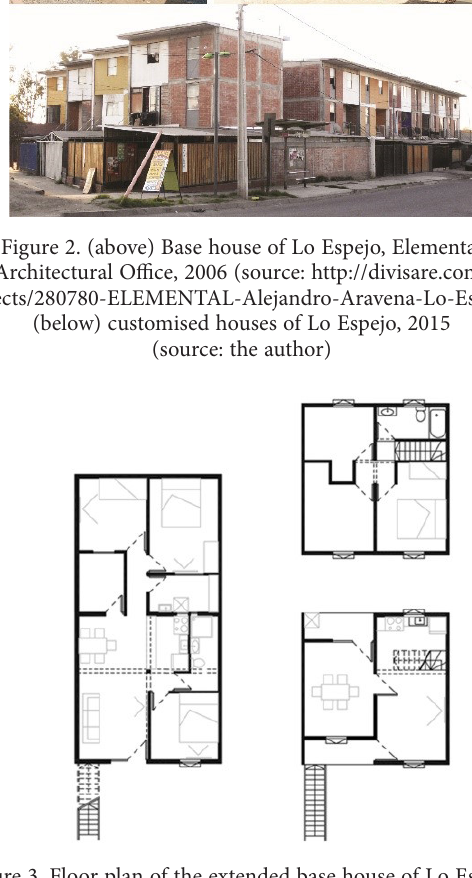
Figure 3. Floor plan of the extended base house of Lo